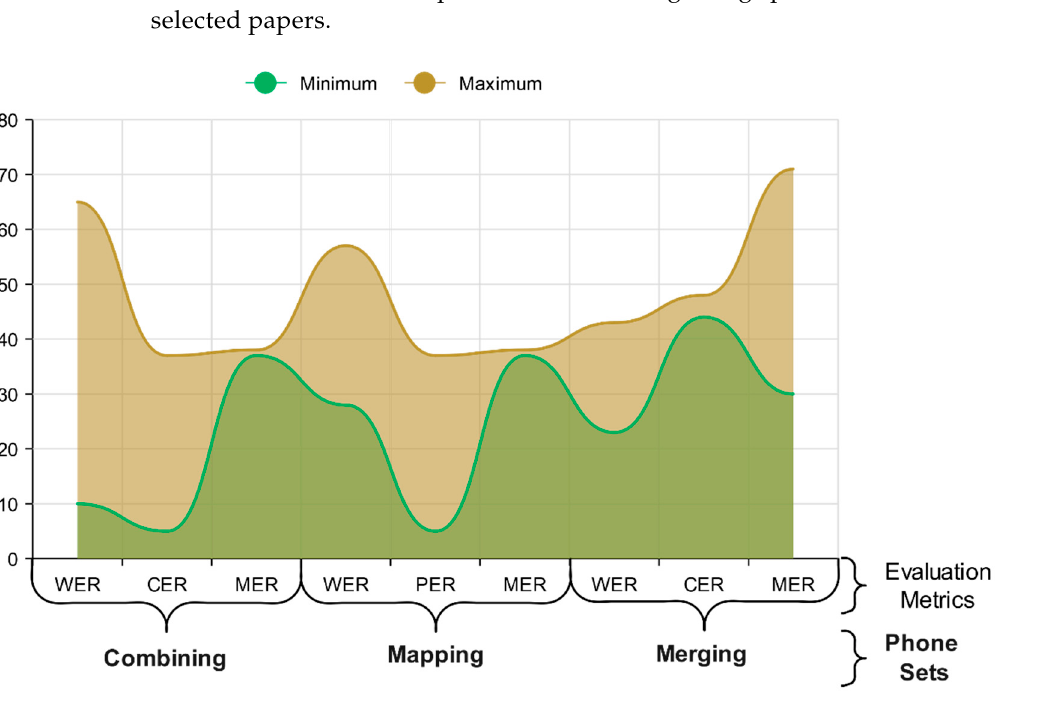
Figure 2. The overall results of the evaluation of ASR performance in recognizing speech with CS conducted in the selected papers.